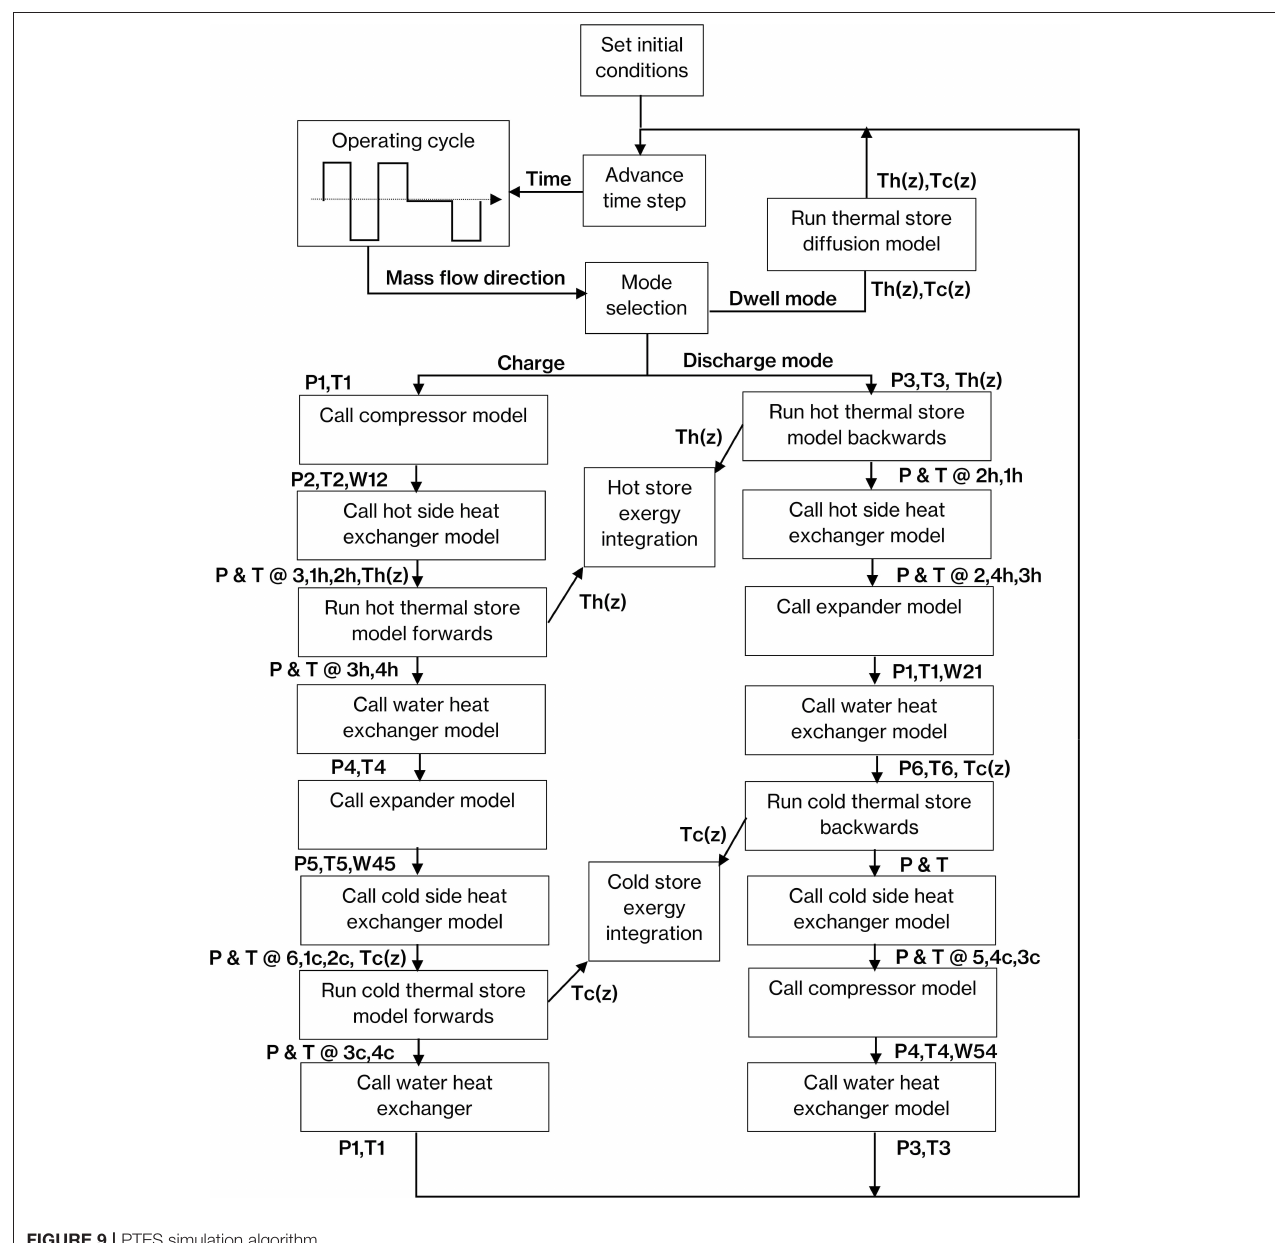
FIGURE 9 | PTES simulation